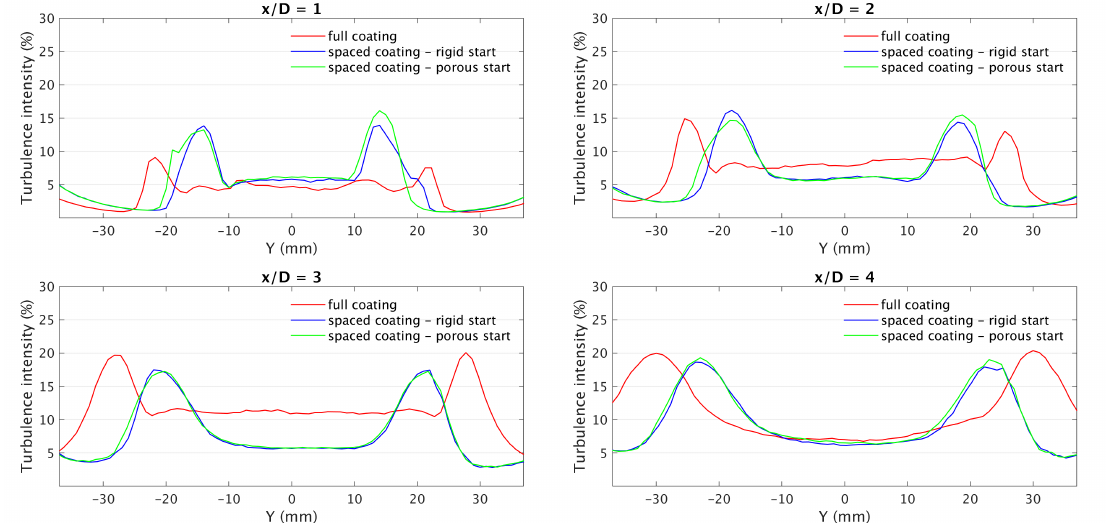
Figure 23. Turbulence intensity graph for cylinders 21 and 23.